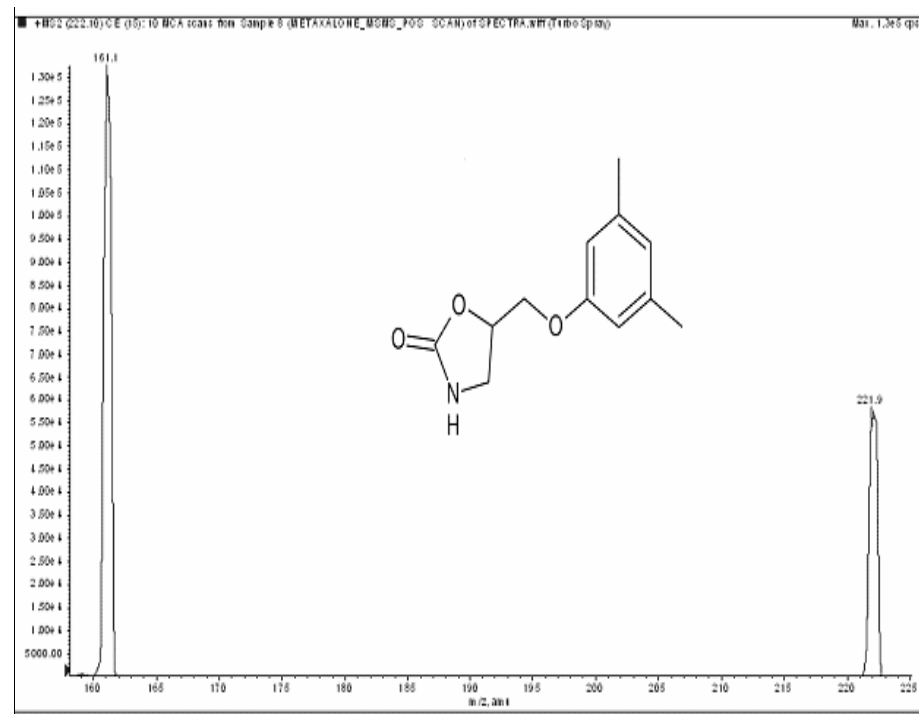
Figure 2. Metaxalone msms scan (222.2 >